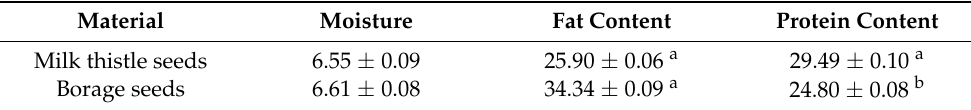
Table 1. Basic chemical composition of seeds (%).